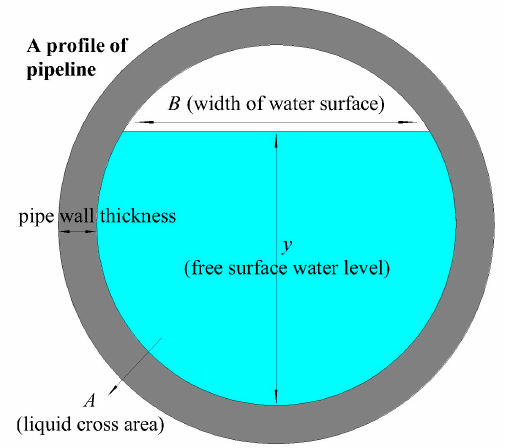
Figure 2. Parameters in the profile of a pipeline.